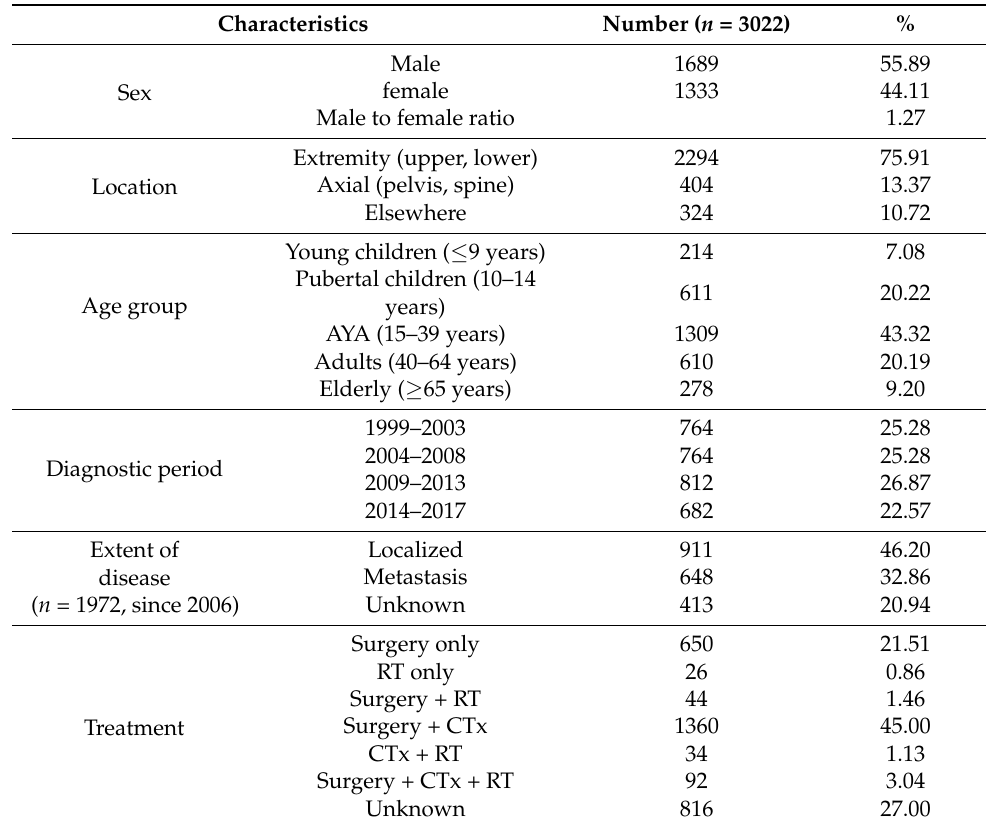
Figure 1. Age distribution of patients with osteosarcoma. Table 1. Characteristics of osteosarcoma cases diagnosed between 1999 and